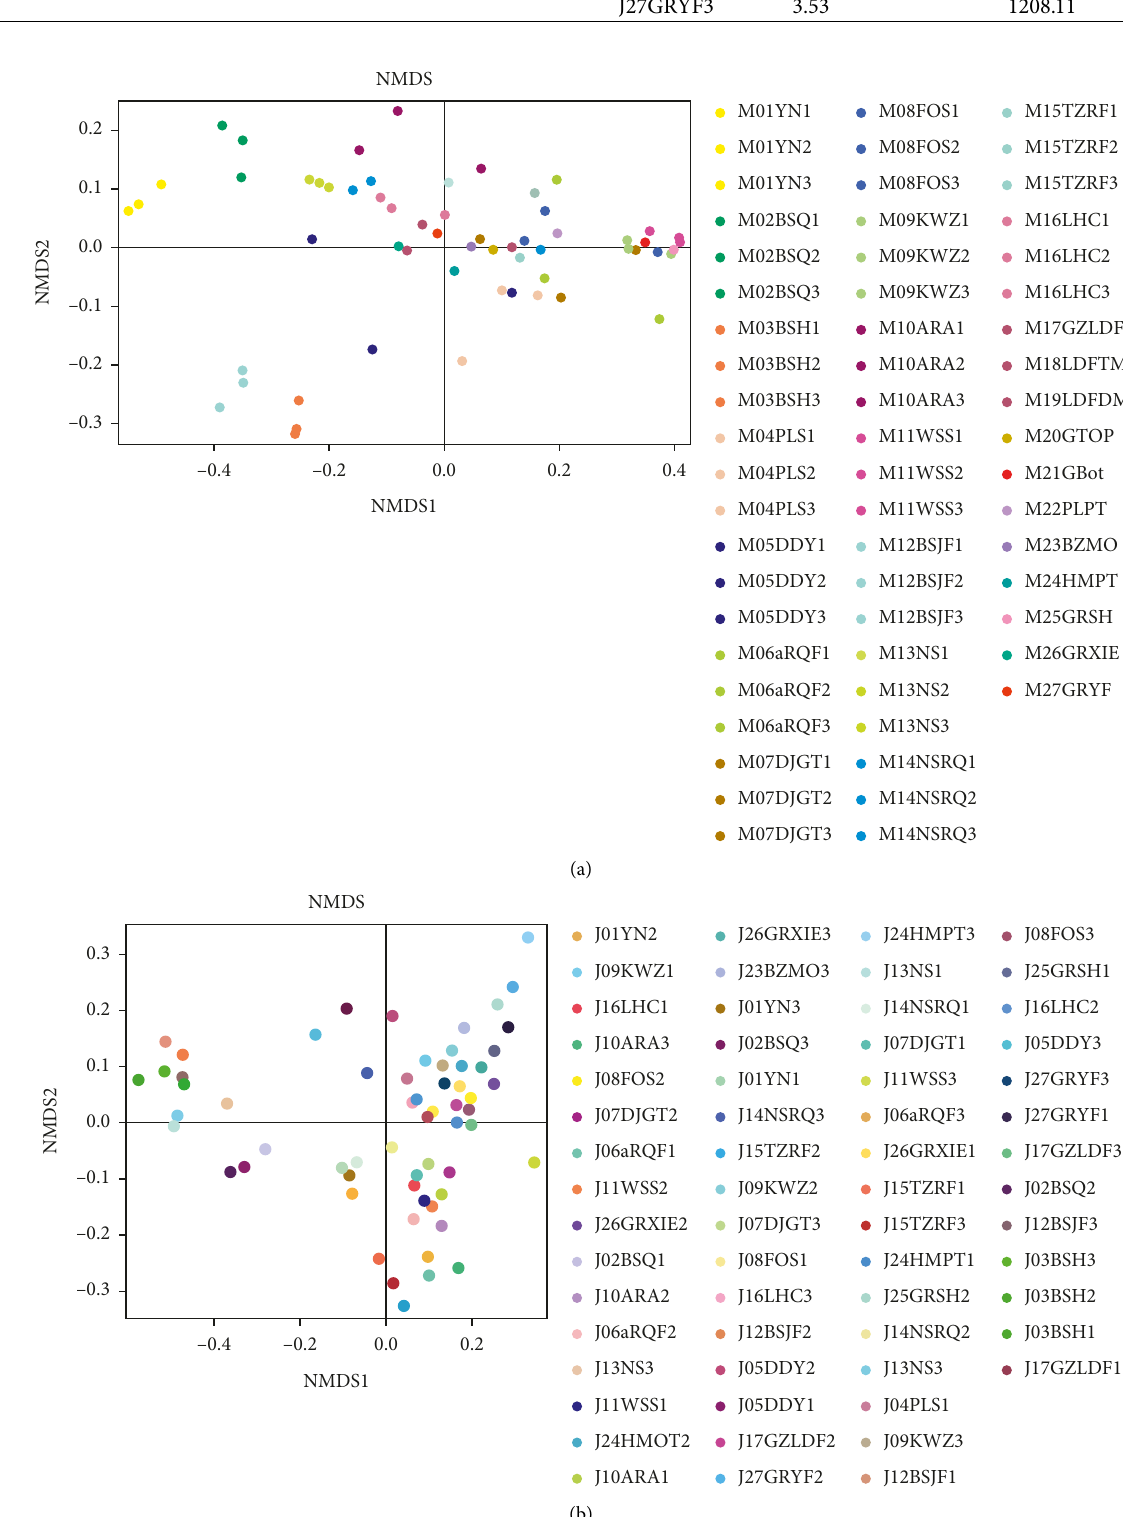
Figure 4: Nonmetric multidimensional scaling (NMDS) analysis of bacterial community composition in infant milk formula production line samples in spring (a) and summer (b) at the genus